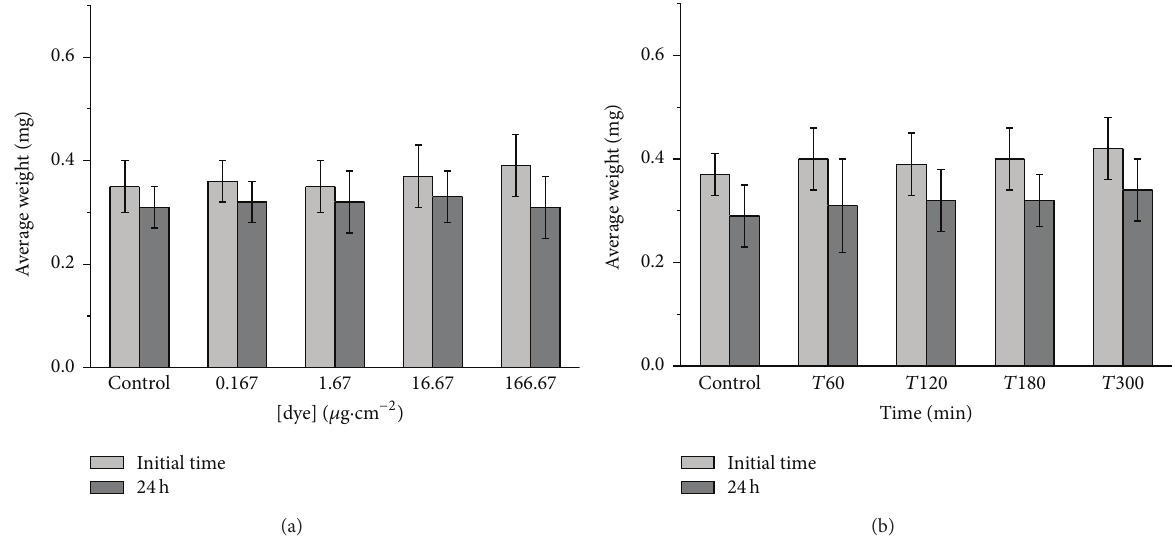
Figure 9: Evaluation of the concentrations of (a) carboxylic acids and (b) SO 4−2 and NH 4+ ions, followed by ion chromatography, formed during solar CPC photodegradation of 30mgL −1 IC with supported TiO 2 in real MWWTP secondary effluent.